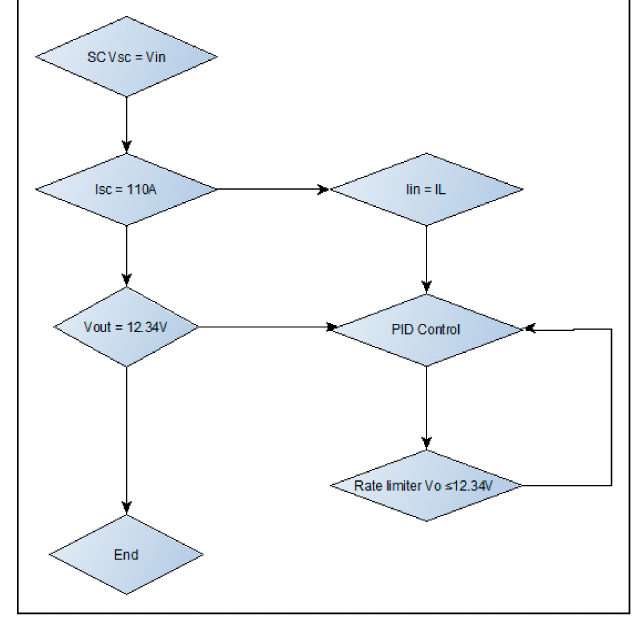
Figure 6. Buck-boost DC/DC converter for the supercapacitor